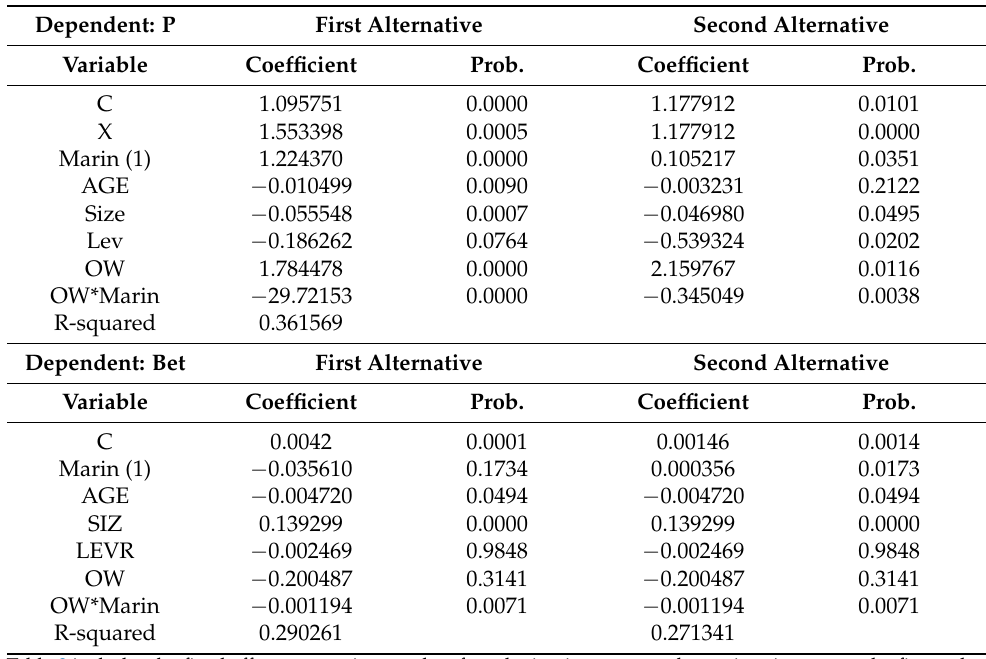
Table 8 includes the fixed effects regression results of marketing investment alternatives impact on the firm value P and systematic risk Bet with white cross-section to avoid heteroskedasticity impact and control variables,